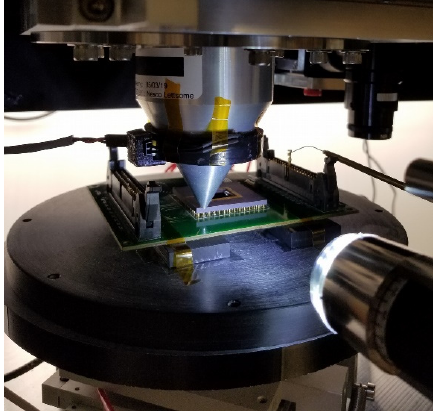
Figure 2. Failing sample under the SQUID sensor.